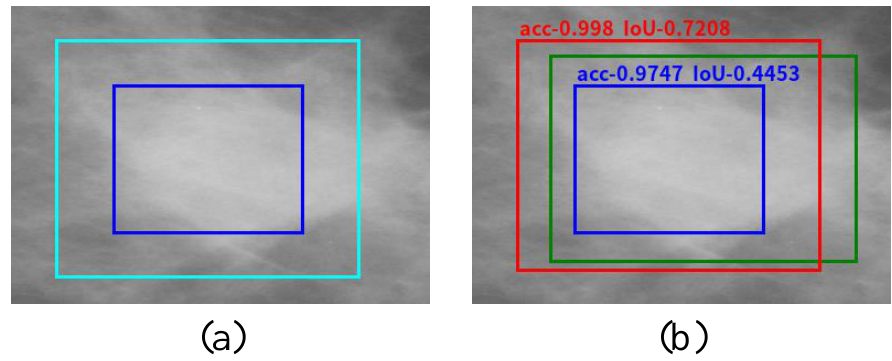
Figure 13. Optimization of breast mass bounding box. ( a ) shows the rough bounding box of the breast mass generated by the image template matching method (blue rectangle) and the search range for the effective resolution by PSO, respectively. ( b ) shows the regressed bounding box of the breast mass (red